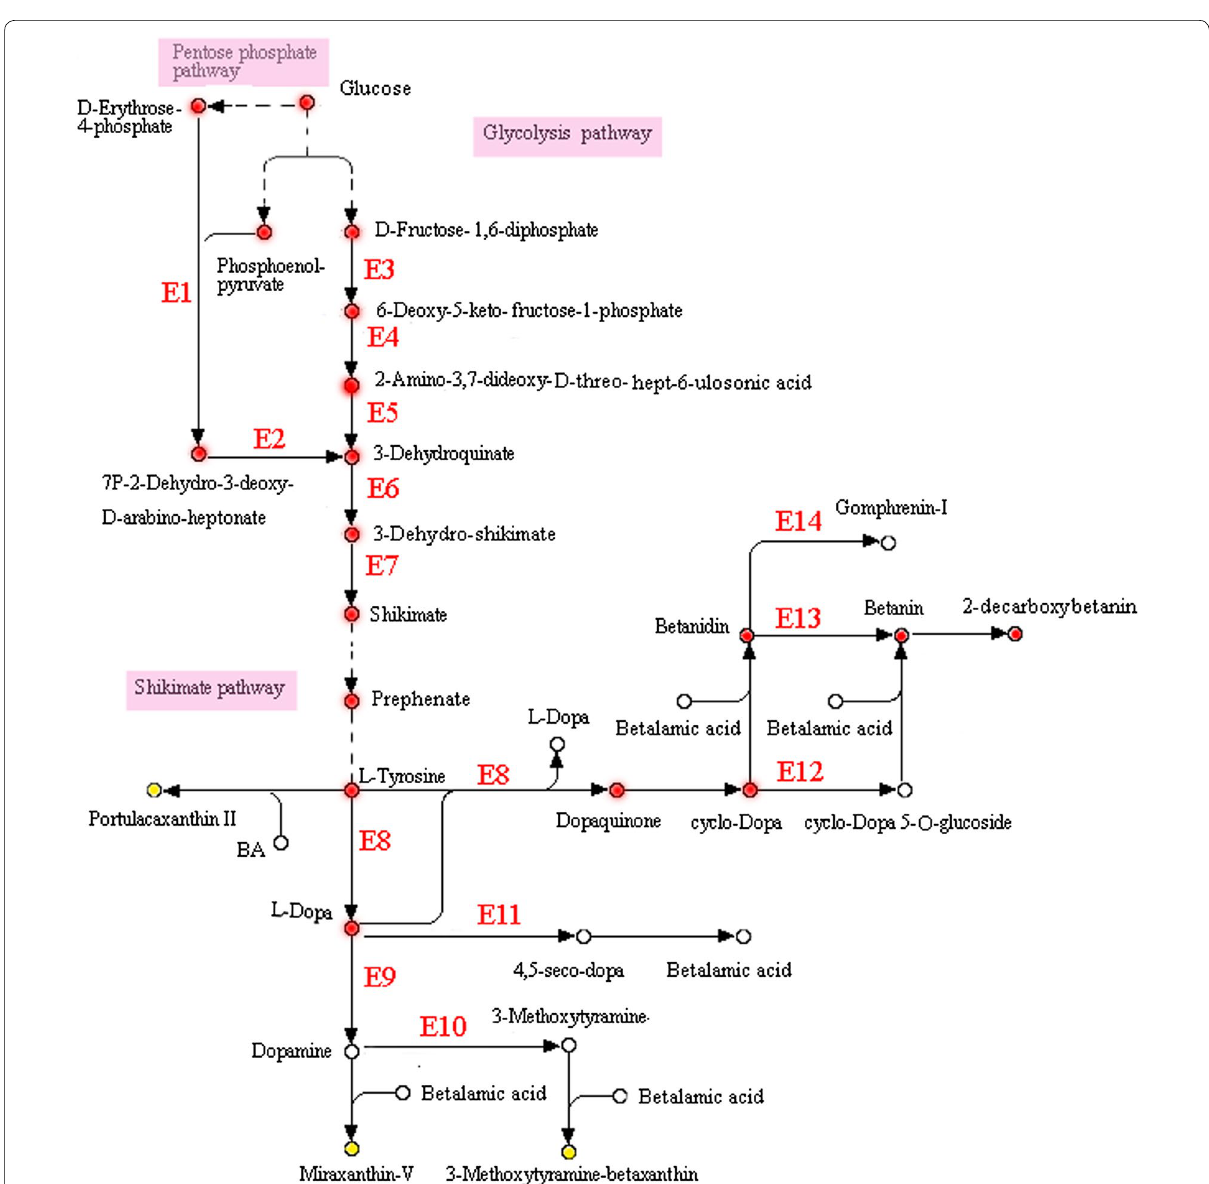
Fig. 6 Simplified 2-decarboxybetanin biosynthetic pathway generated by KEGG enrichment analysis in P. novae - zelandiae . E1: 3-deoxy-7-phospho- heptulonate synthase [EC:2.5.1.54]; E2: 3-dehydroquinate synthase [EC:4.2.3.4]; E3: 6-deoxy-5-ketofructose-1-phosphate synthase [EC:2.2.1.11]; E4: 2-amino-3,7-dideoxy-D-threo-hept-6-ulosonate synthase [EC: 2.2.1.10]; E5: 3-dehydroquinate synthase II [EC:1.4.1.24]; E6: 3-dehydroquinate dehy- dratase I [EC:4.2.1.10]; E7: shikimate dehydrogenase [EC:1.1.1.25]; E8: tyrosinase [EC:1.14.18.1]; E9: aromatic-L-amino-acid decarboxylase [EC:4.1.1.28]; E10: catechol O-methyltransferase [EC:2.1.1.6]; E11: 4, 5-DOPA dioxygenase extradiol [EC:1.13.11.-]; E12: cyclo-DOPA 5-O-glucosyltransferase [EC:2.4.1.-]; E13: betanidin 5-O-glucosyltransferase [EC:2.4.1.-]; E14: betanidin 6-O-glucosyltransferase